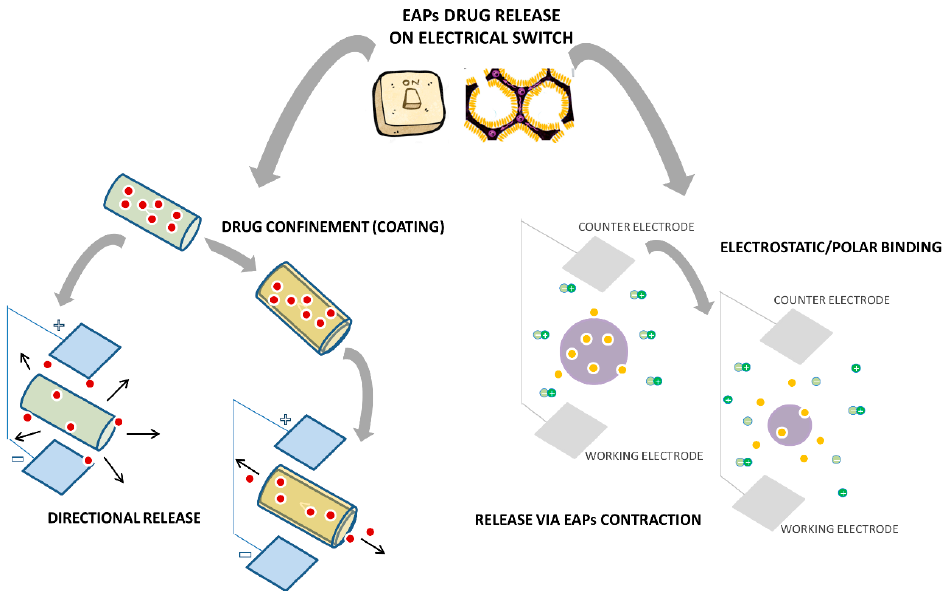
Figure 5. Mechanisms of “on demand” molecular release triggered by electrical stimulation of EAPs.